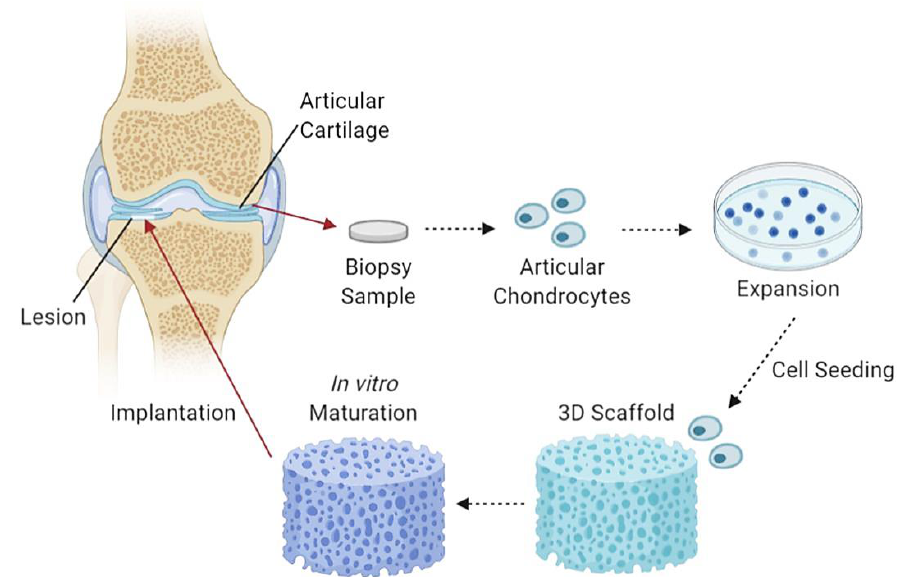
Figure 4. An illustrative flow diagram of cartilage tissue engineering. It begins with taking a biopsy sample of articular cartilage containing articular chondrocytes, which are then cultured, seeded and incorporated into a 3D scaffold, left to mature partially in in vitro conditions and followed by scaffold implantation into chondral lesions [116]. Created with Biorender.com (Accessed date: 10 February 2021).